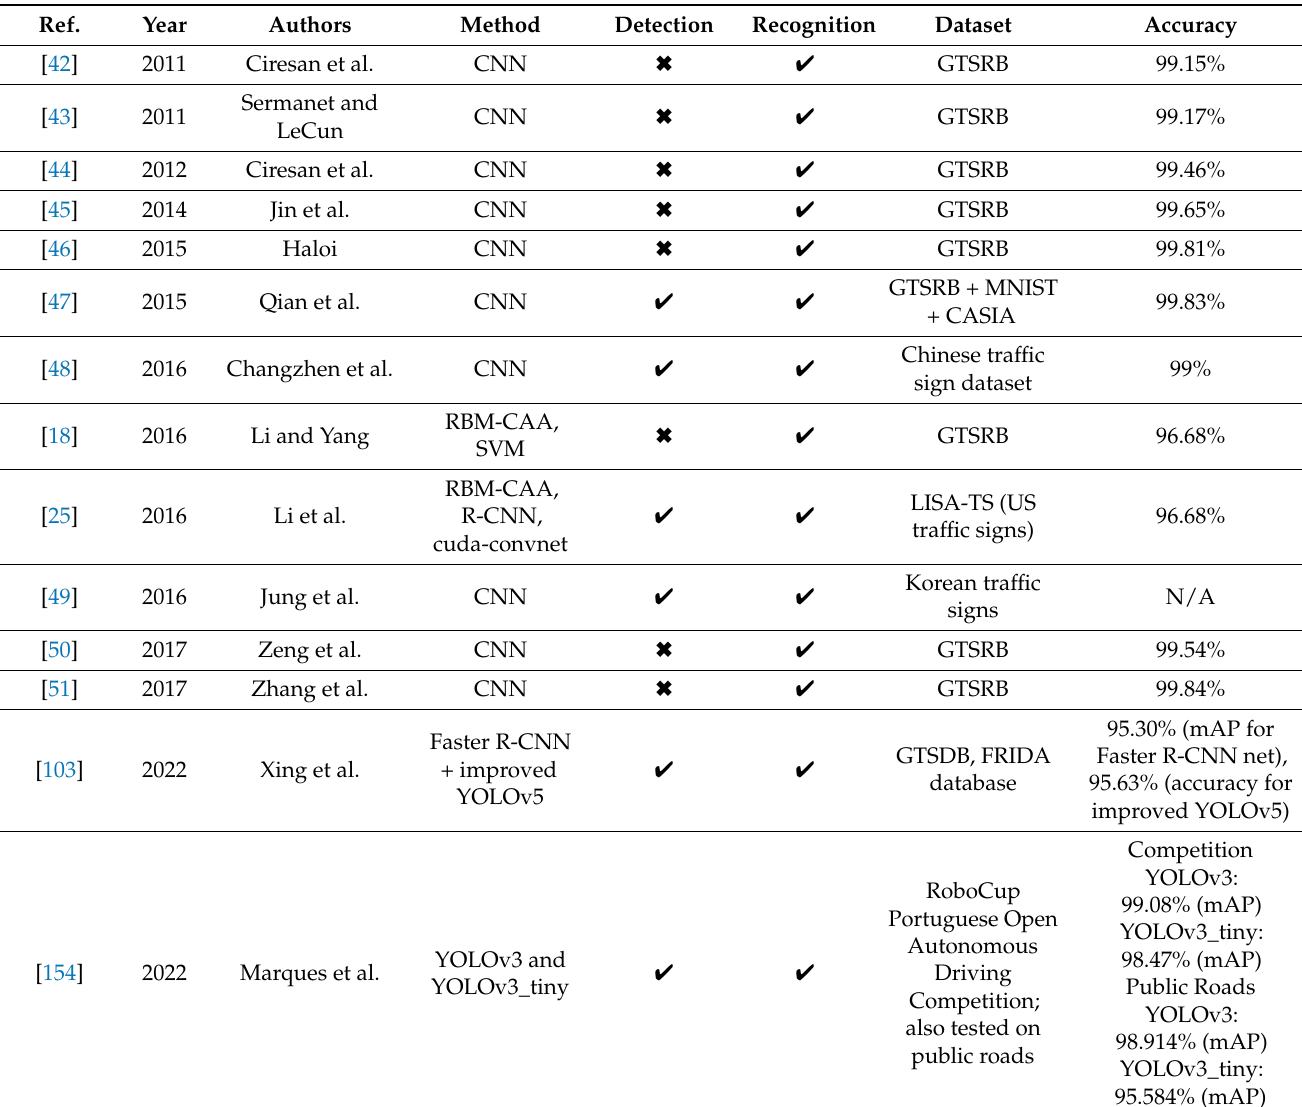
Table 4. Traffic Sign Detection and Recognition Studies with DL Methods.